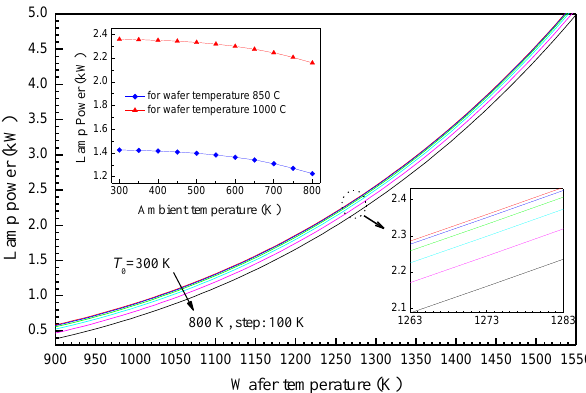
Figure 5. The lamp power vs. the wafer temperature at different ambient temperature. The top-left inset: the lamp power vs. the ambient temperature for the annealing temperature 1123 K (850 °C) and 1273 K (1000 °C); the lower-right inset: enlarged view near the wafer temperature of 1000 °C.